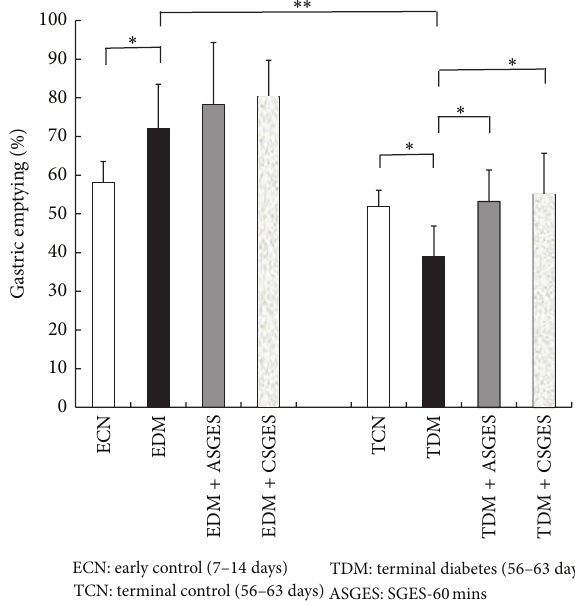
Figure 2: Effect of SGES on gastric emptying. The gastric empty- ing rates were significantly different between control groups and diabetic groups. Gastric emptying rate was faster in EDM than the age-matched control group but slower in TDM. ASGES and CSGES accelerated gastric emptying in TDM significantly but only had a little effect on EDM. There were no significant differences between EDM and EDM with SGES. Data are presented as means ± SD. ∗ 𝑃 < 0.05 , ∗∗ 𝑃 < 0.01